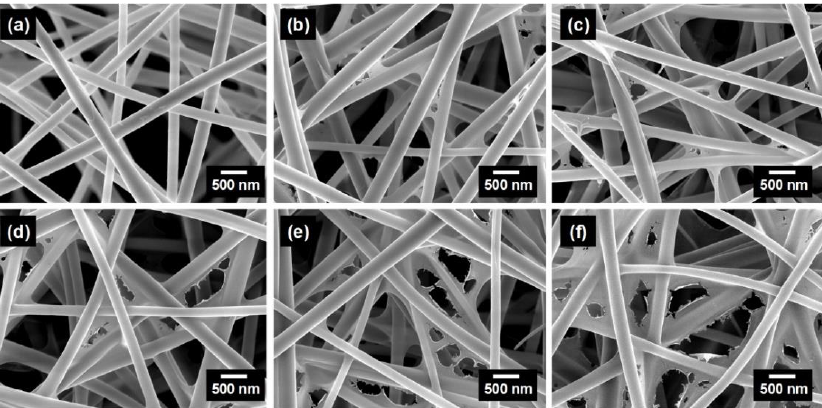
Figure 2. FE-SEM images of ( a ) SiO 2 NFMs and the composite NHMs prepared from different CCA-to-PVA loading ratios of ( b ) 1:1, ( c ) 2:1, ( d ) 3:1, ( e ) 4:1, and ( f ) 5:1. FT-IR spectra, pore size distributions, and adsorption capability of the corresponding nanofibrous materials are presented in Figure 3. Significantly, the corresponding charac- teristic absorption peak around 1728 cm −1 gradually enhanced (Figure 3a), demonstrating the increased crosslinking and carboxylate degree of the functional CCA-co-PVA hydro- gel film [33]. In contrast, the static lysozyme adsorption capacity of the NHMs gradually increased to 600 mg g −1 as the CCA-to-PVA loading ratio increased to 4:1 and then kept balance (Figure 3b). The differential distribution of hydrogel film also greatly affected the pore structure of the NHMs. As shown in Figure 3c, the initial SiO 2 NFMs presented a relatively large pore size of mainly around 2.9 μm. The average pore size of NHMs grad- ually decreased, and less than 2.0 μm at a CCA -to-PVA loading ratio of 5:1. Due to the declined pore size, PBS flux of these membranes also decreased from about 8000 L m −2 h −1 to 2000 L m −2 h −1 (Figure 3d). By comprehensively analyzing the above experimental re- sults, the CCA-to-PVA loading ratio of 4:1 was selected to conduct the following experi- ments.